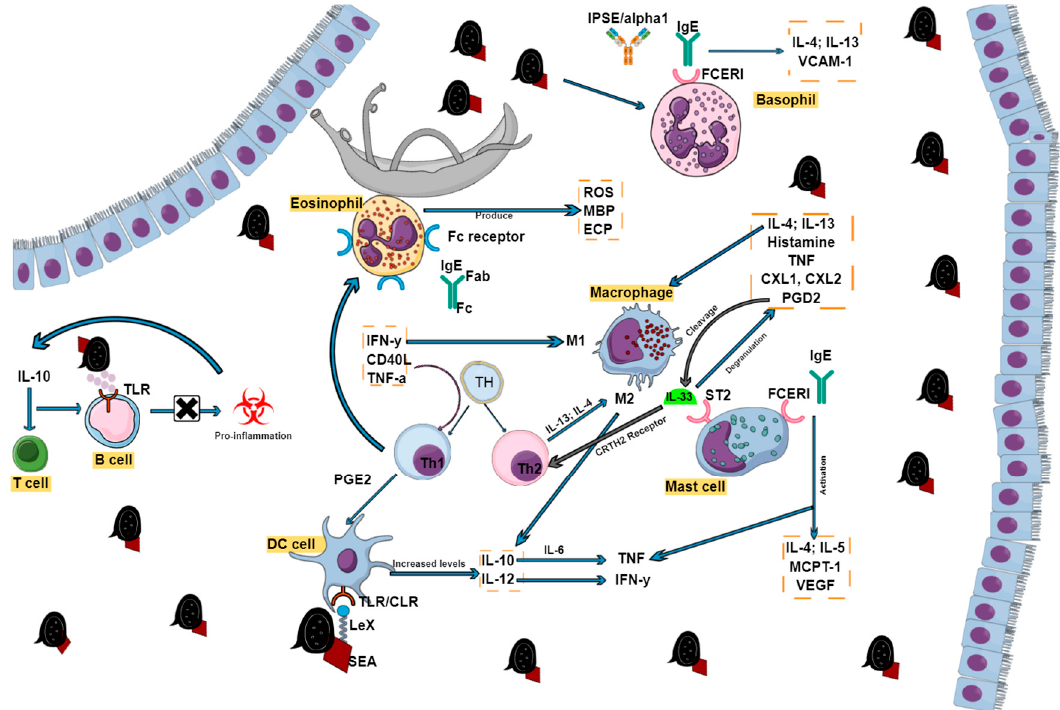
Figure 2. Effector cell activation during schistosome infection. The presence of inflammatory cells in the form of lymphocytes (B and T cells), macrophages, eosinophils, dendritic cells, mast cells, and basophils all play crucial roles in schistosome disease progression. Various receptors and cytokines drive their functions, which may sometimes overlap but are all the same interconnected.